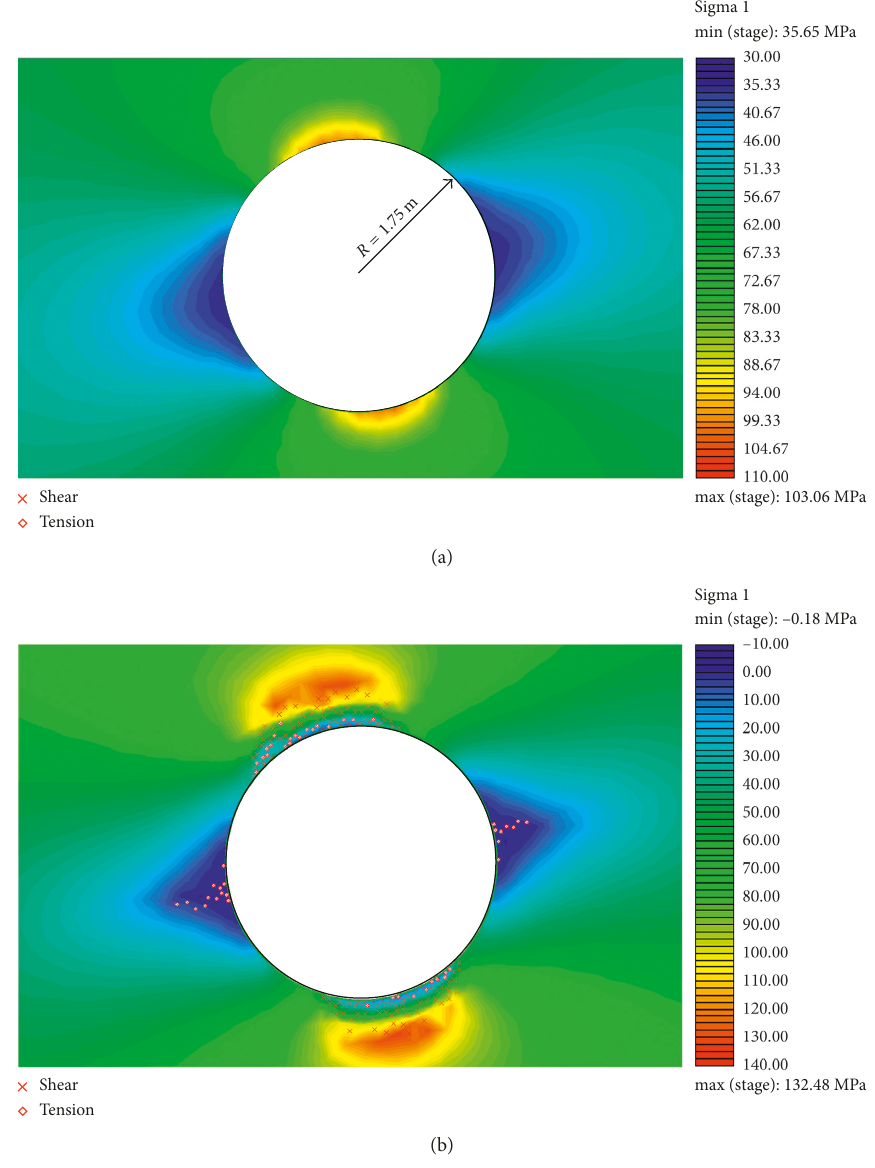
Figure 8: Major principal stress 1 contours of the intact FEM model using the DISL approach [16]. (a) Elastic response of the model at 60% of the induced stresses (tunnel advancing), and (b) final model state after the completion of the excavation. Yielded elements in shear ( in tension ( ) are plotted. Yielded elements in tension at the crown and floor of the excavation are the result of extensile fracturing. σ Numerical results are consistent with the results by ○